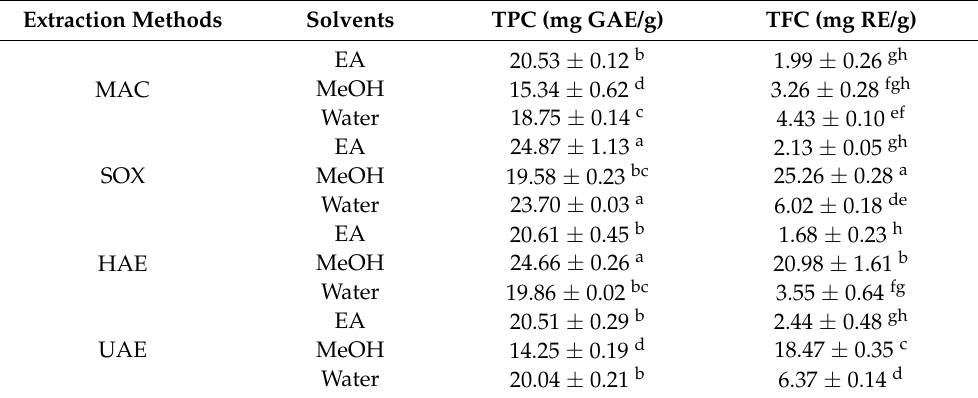
Values are reported as mean ± SD of three parallel measurements. MAC: Maceration; SOX: Soxhlet; HAE: Homogenizer assisted extraction; UAE: Ultrasound assisted extraction. TPC: Total phenolic content; TFC: Total flavonoid content; GAE: Gallic acid equivalent; RE: Rutin equivalent. Different letters in same column